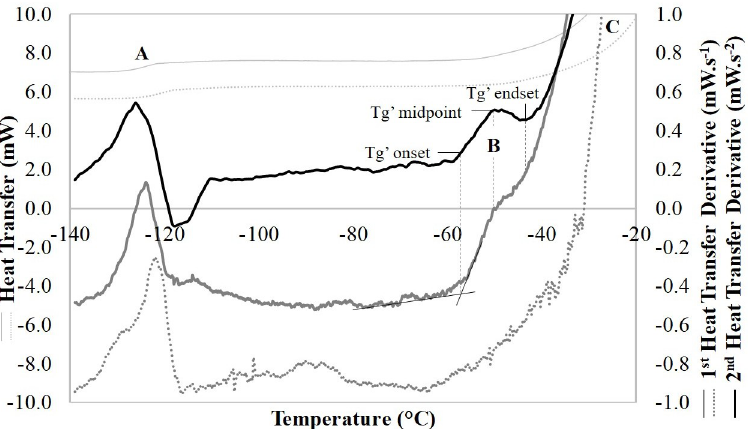
In samples initially cooled at 1˚C min -1 to -150˚C, ice nucleation in the extra-cellular compart- ment occurred between -6˚C and -9˚C. An endothermic event (event A, Fig 2) was observed by DSC during warming at -123˚C, representing the midpoint of the glass transition of the extracellular medium (DMSO, Tg’e). An endothermic event was observed on further warming